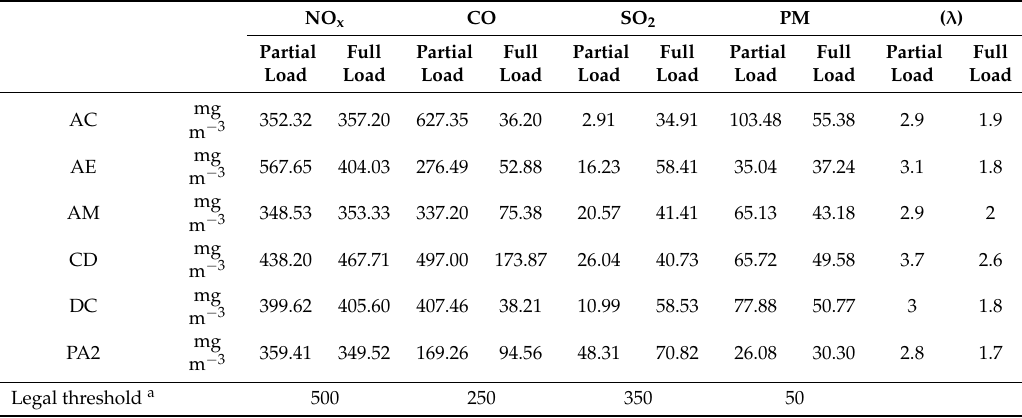
Table 5. Mean values of CO, NO x , SO 2 , PM, and excess air fuel ratio ( λ ) emissions during combustion of solid fuel briquettes at partial load (60 kW) and full load (120 kW).